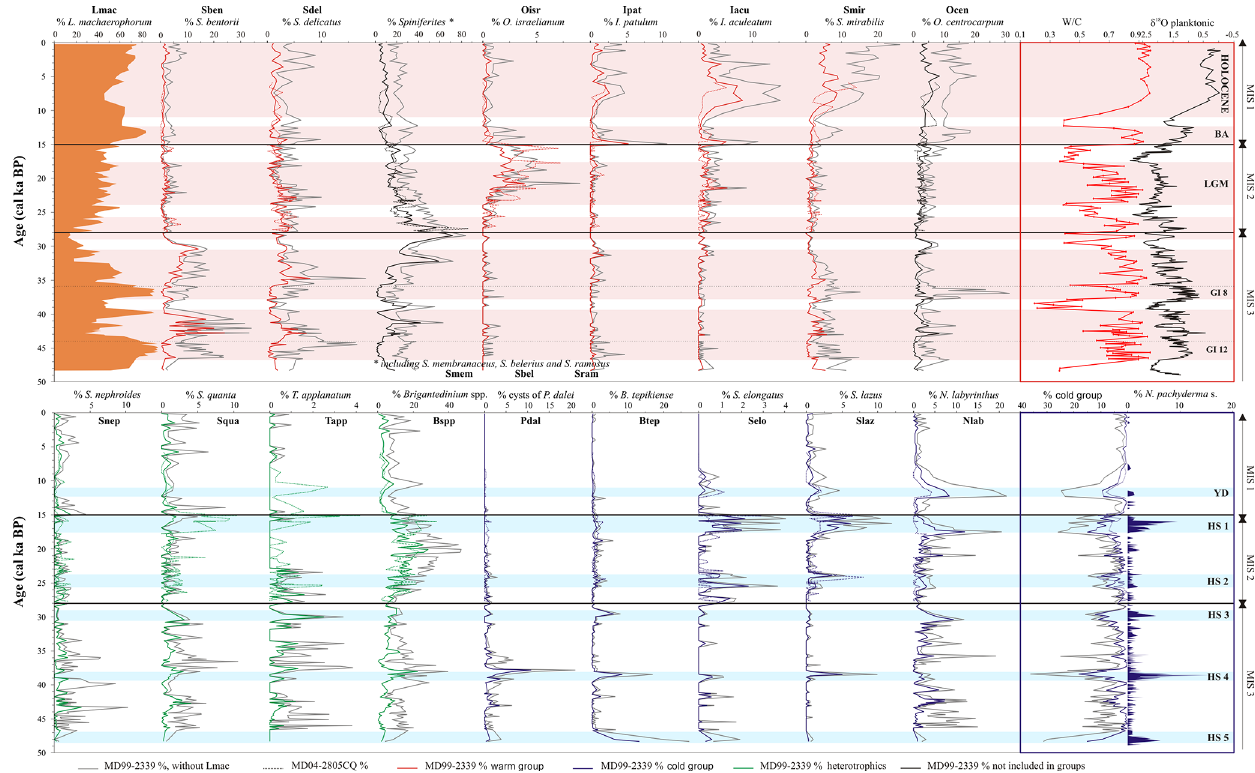
Figure 5. Data from core MD99-2339 against age (calkaBP): major taxa occurring with values higher than 2% in dinocyst assemblages from core MD99-2339 (0–48kaBP; 0–1854cm). Red, blue and green respectively indicate the “warm”, “cold”, and “heterotrophic” groups. W/C: warm to cold ratio. The trends shown in grey are calculated by excluding Lingulodinium machaerophorum from the main dinocyst sum, while coloured curves (colours explained in the figure) depict the whole assemblage considering all species. MD04-2805 CQ dinocyst data are also represented over the 28kaBP so as to illustrate similarities between the assemblages from the central (MD99-2339, this study) and southern (MD04-2805 CQ; Penaud et al., 2011a) Gulf of Cadiz. Pink bands indicate warmer intervals (including BA, Bölling–Alleröd; LGM, Last Glacial Maximum; and GI, Greenland Interstadial) and blue bands indicate colder events (HS, Heinrich Stadials; YD, Younger